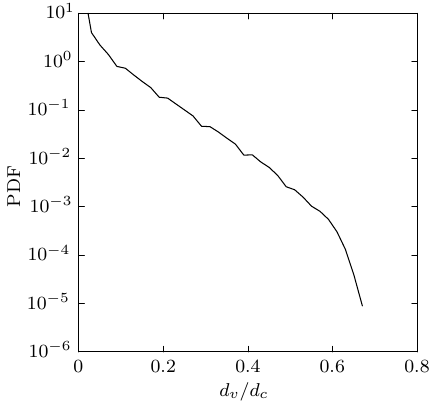
Figure 6. Distribution of normalized total height of cloud